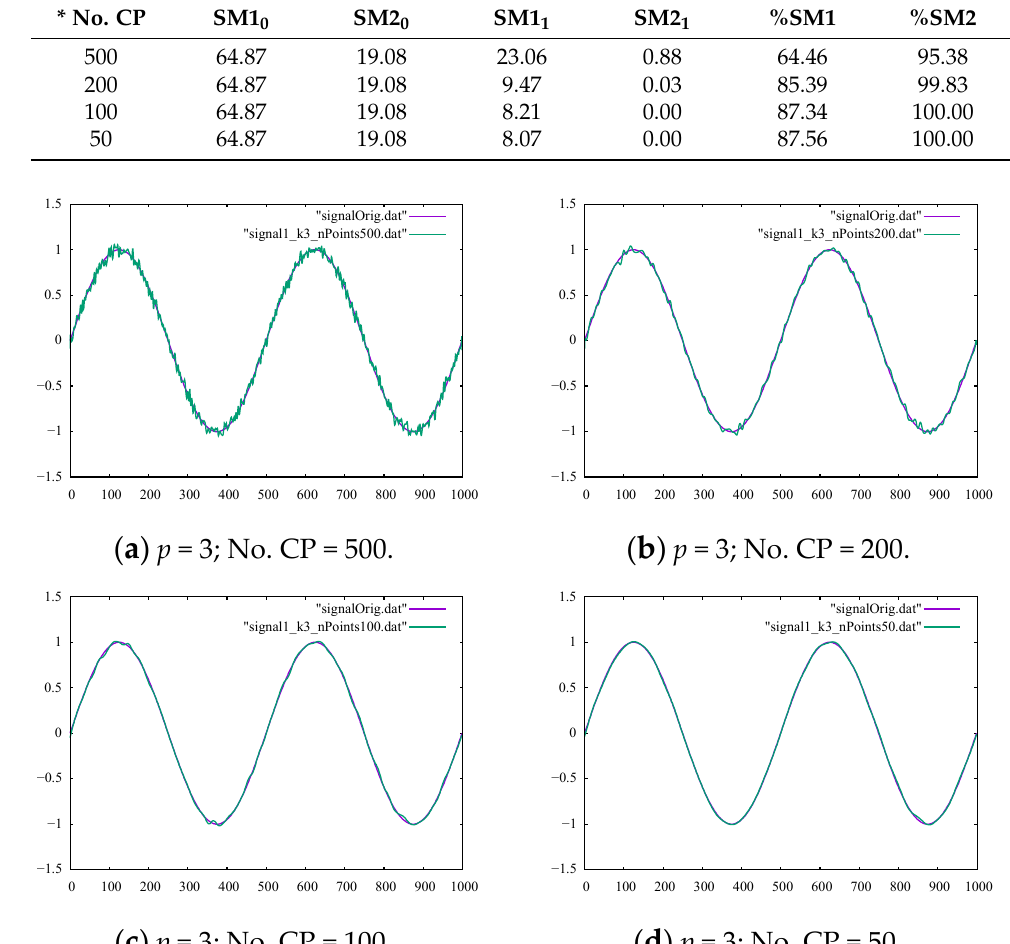
Table 3. Performance metrics of the Kalman filter using different measurement error E mea values. Measurement Error